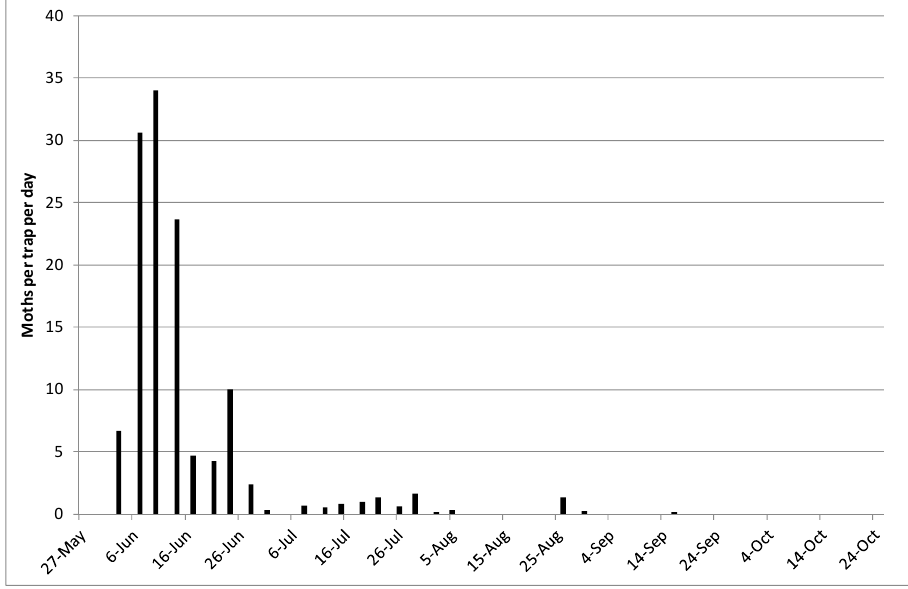
Figure 3. Pheromone trap captures of P. xylostella at Wellesbourne in 2016 using conventional Delta traps (moths per trap per day).